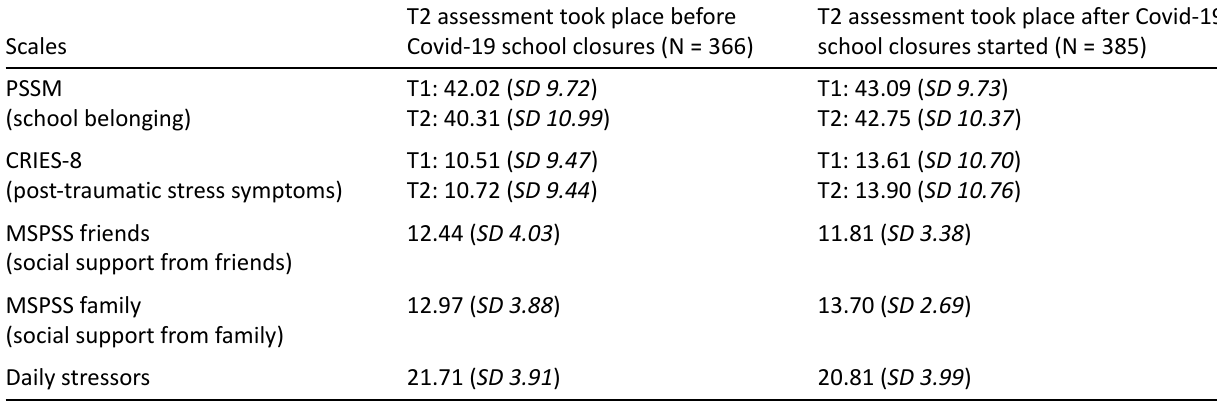
Table 2. Average scores on the scales per T2 assessment Covid‐19 group (N = 751). T2 assessment took place